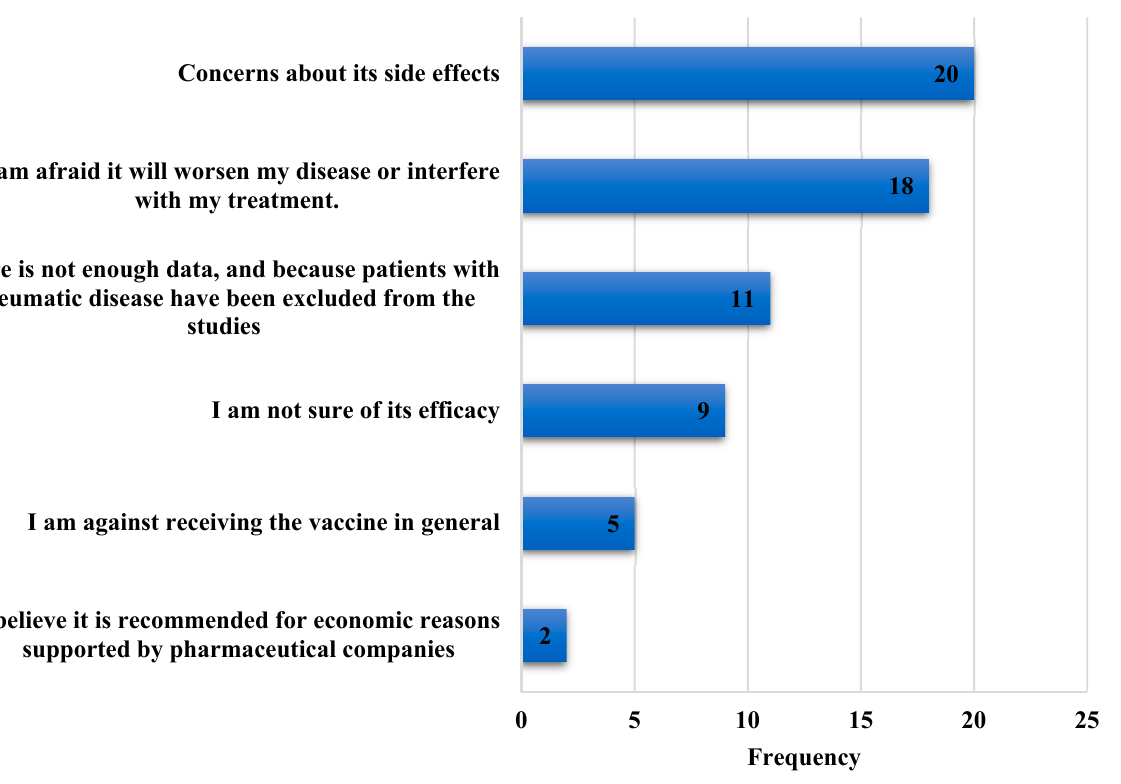
Figure 2. Bar chart showing the frequency of reasons for refusing to receive the SARS-CoV-2 vac- cine.